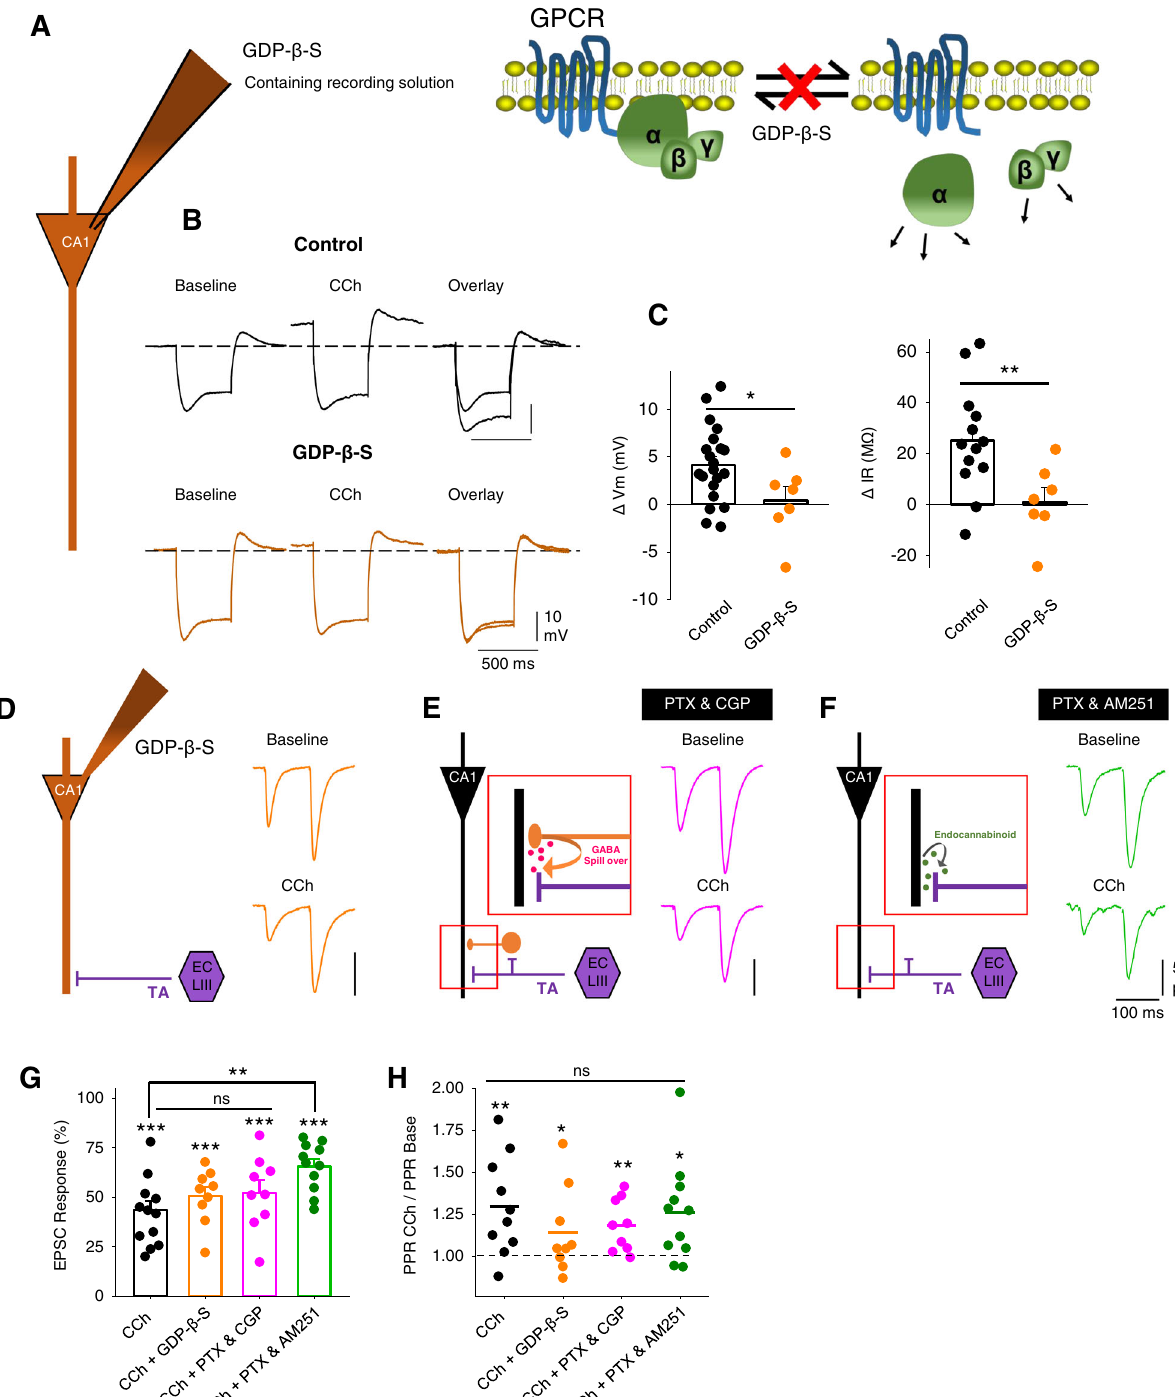
fi rst spike (Supplementary Fig. S6A – C spike baseline, 397 ± 56 ms vs CCh i ≠ 0, 483 ± 66 ms, p > 0.05). 1 1 ; baseline, 298 ± 58 ms vs CCh i ≠ 0, 775 ± 83 ms, p < 0.001). With current injection However, with current injection removed and CA1 neurons removed and membrane potential allowed to depolarise, spike allowed to depolarise spike probability increased and the delay to probability increased slightly but failed to return to baseline levels the fi rst spike shortened (Supplementary Fig. S6A 2 – C 2 ; P spike 0.61 ± 0.06, p < 0.01 vs baseline; delay to spike 280 ms ± 27 ms, (Supplementary Fig. S6A 1 – C 1 ; P spike 0.33 ± 0.05, p < 0.05 baseline vs CCh i = 0). In contrast, CCh application had little effect on TA p < 0.05 vs pathway driven spike probability and delay to the fi rst spike when the membrane potential was maintained at baseline levels (Supplementary Fig. S6A 2 – C 2 ; P spike baseline, 0.33 ± 0.06 vs CCh i ≠ 0, 0.43 ± 0.08, n = 15 from 10 mice, p > 0.05; delay to